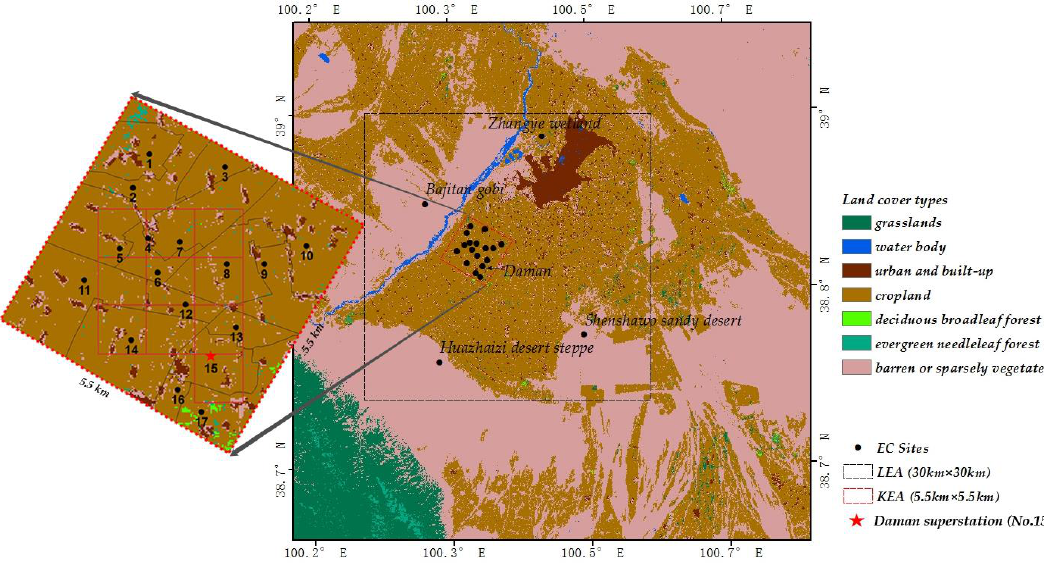
Figure 1. Land cover types (IGBP classification) of the study area and the location of EC sites. LEA: large experimental area, KEA: kernel experimental area.